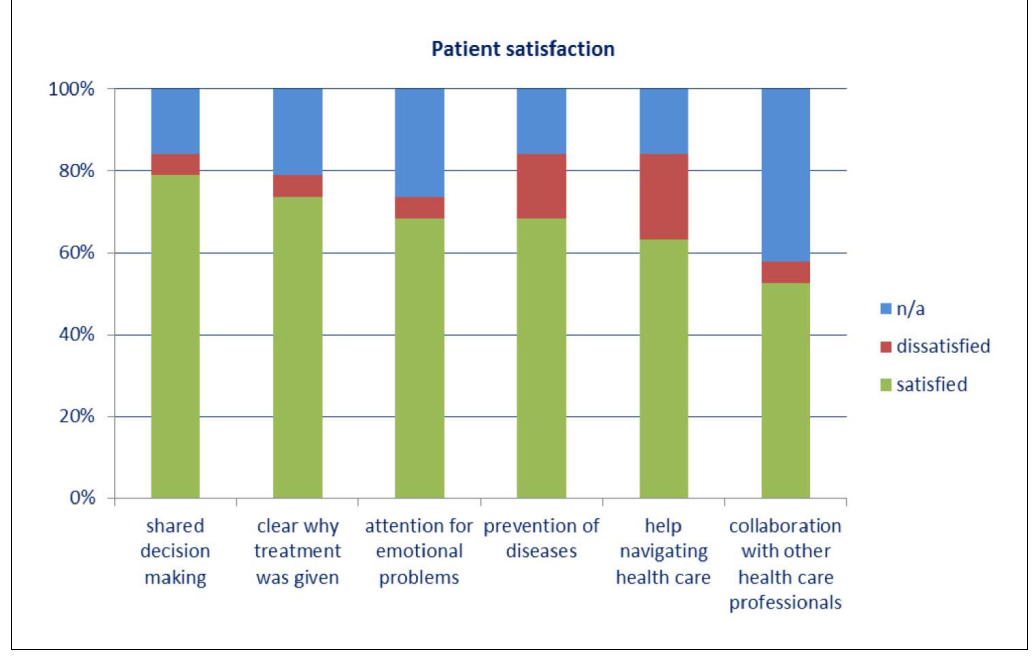
Figure 1. Rating of different components of quality of care n/a= rated as not